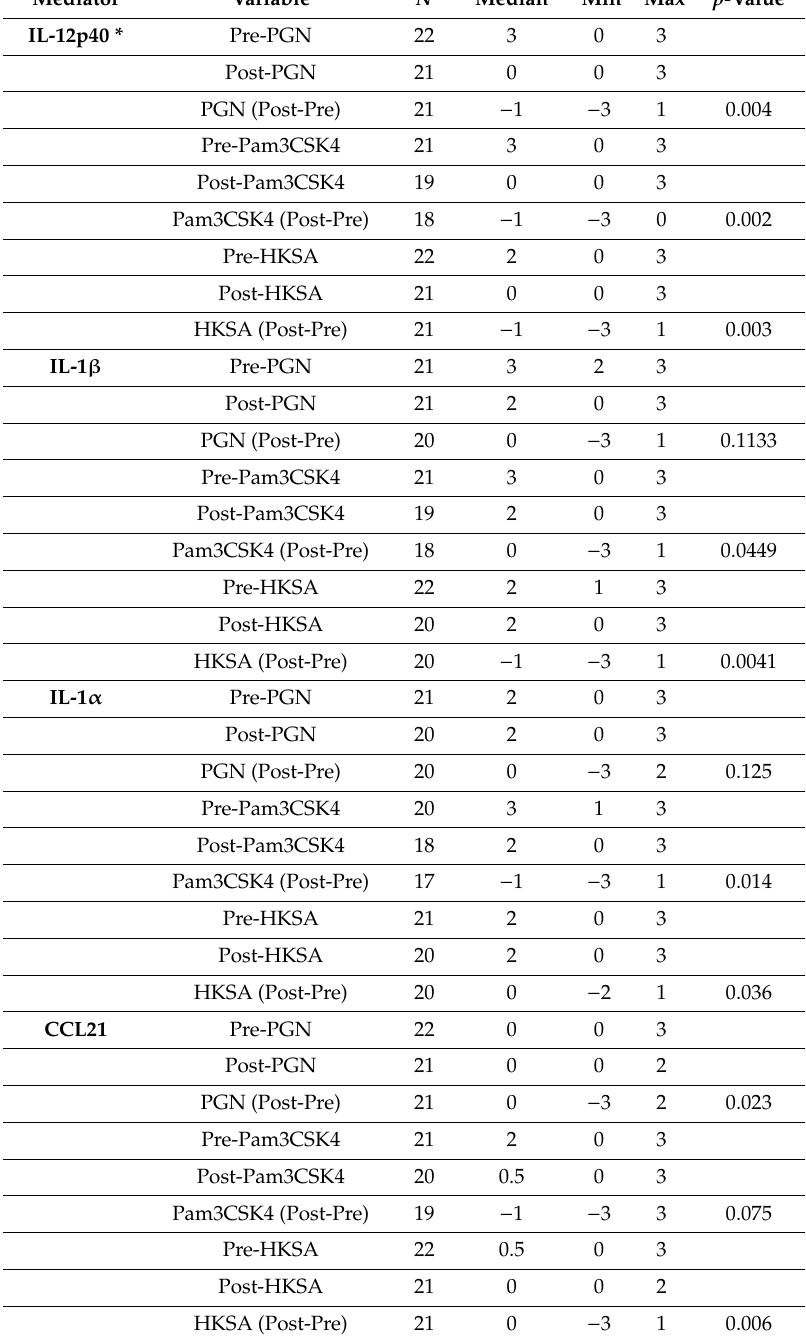
Table 4. Mediators decreased in PBMCs following spinal